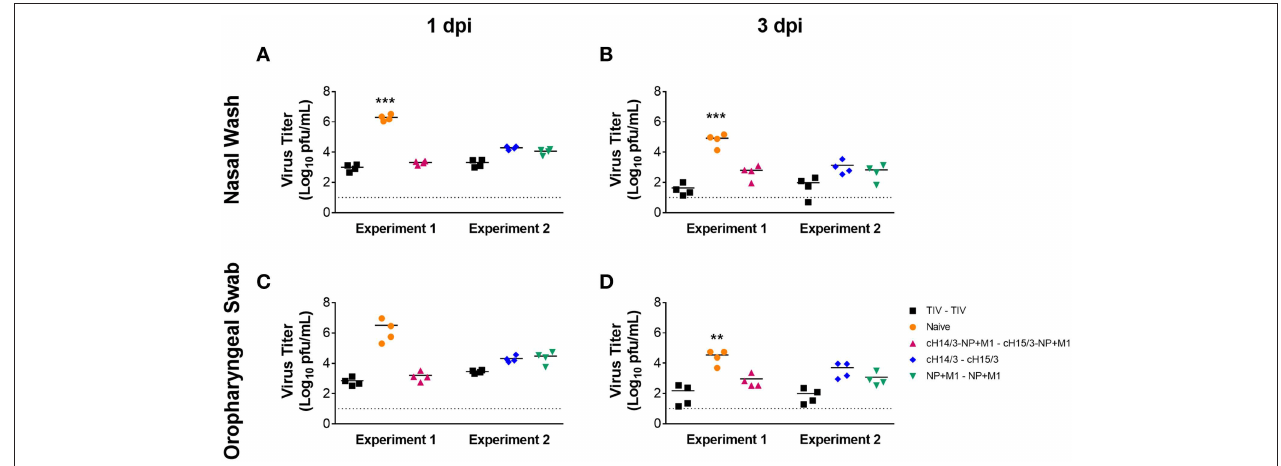
FIGURE 2 | Nasal wash and oropharyngeal titres at days 1 and 3 post-challenge. Ferrets were prime-boosted with TIV or viral vectors (ChAdOx1, then MVA) expressing influenza virus antigens (cHA-NP + M1, cHA, or NP + M1). Six weeks after the boost, ferrets were challenged IN with 10 6 PFU of A/Wyoming/03/2003 (H3N2) virus and nasal washes were collected at days 1 (A) and 3 (B) post-challenge to detect viral titres via plaque assay. Oropharyngeal swabs were also collected at days 1 (C) and 3 (D) post-challenge to determine viral titres. The data are presented as individual replicates and the mean for each group is presented as line. n = 4